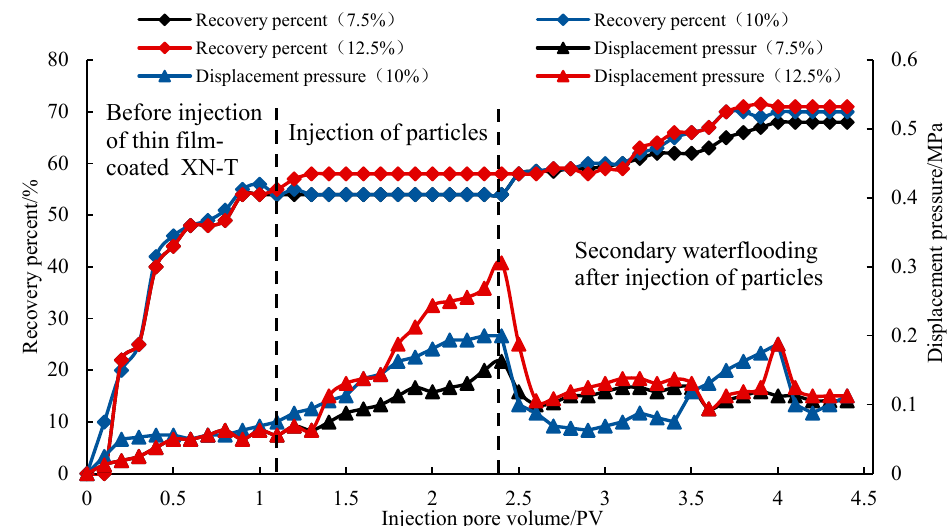
Figure 9. Displacement pressure curves and recovery percent curves at variable particle mass frac- tions.